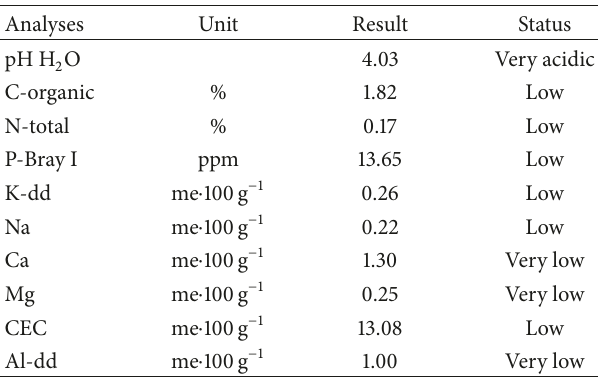
Table 1: Analysis results of soil properties before